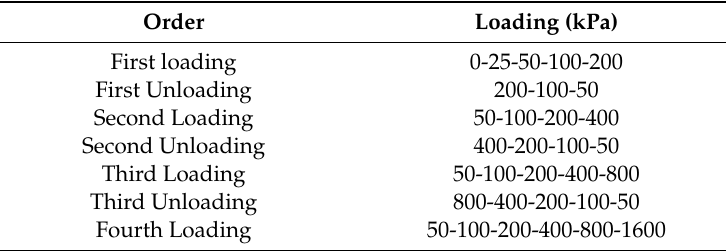
Table 4. Loading procedures in oedometer